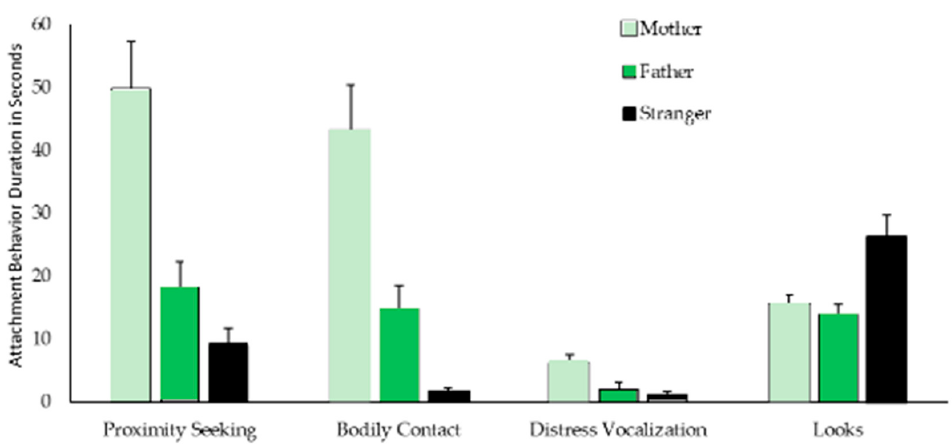
Figure 2. Duration of observed attachment behaviors and looks to mother, father, and stranger (means and SE).